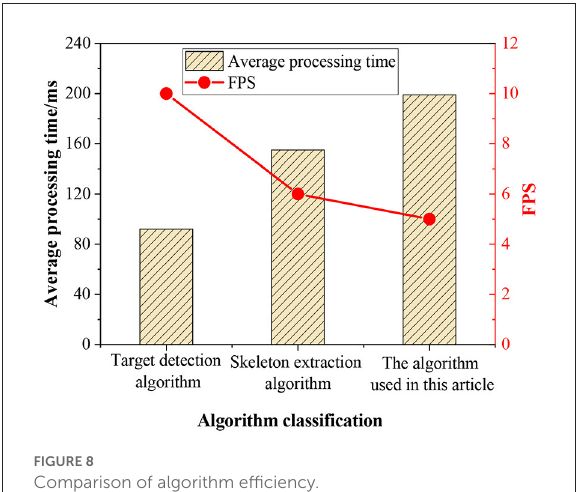
FIGURE8 Comparison of algorithm efficiency.